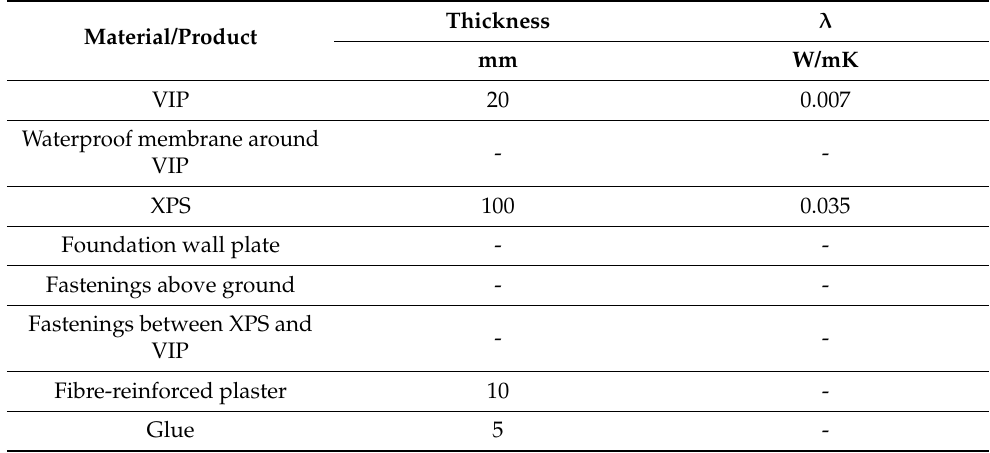
Table 2. Materials used for retrofitting.